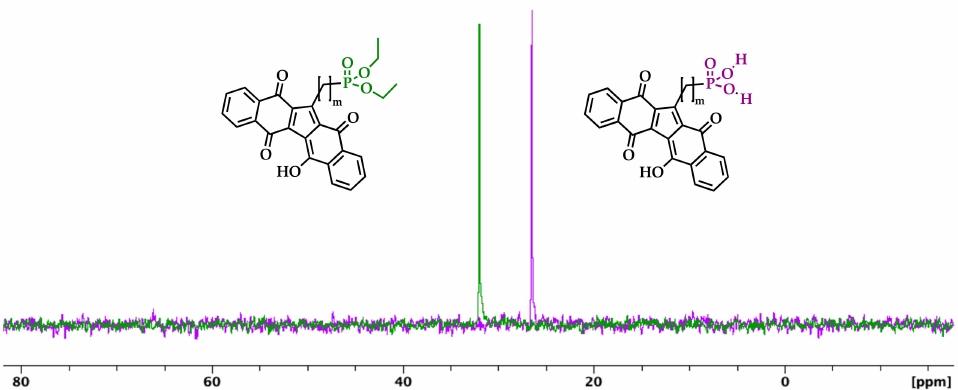
Figure 1. 31 P NMR spectra of 8 (purple) and 5 (green) in DMSO- d 6